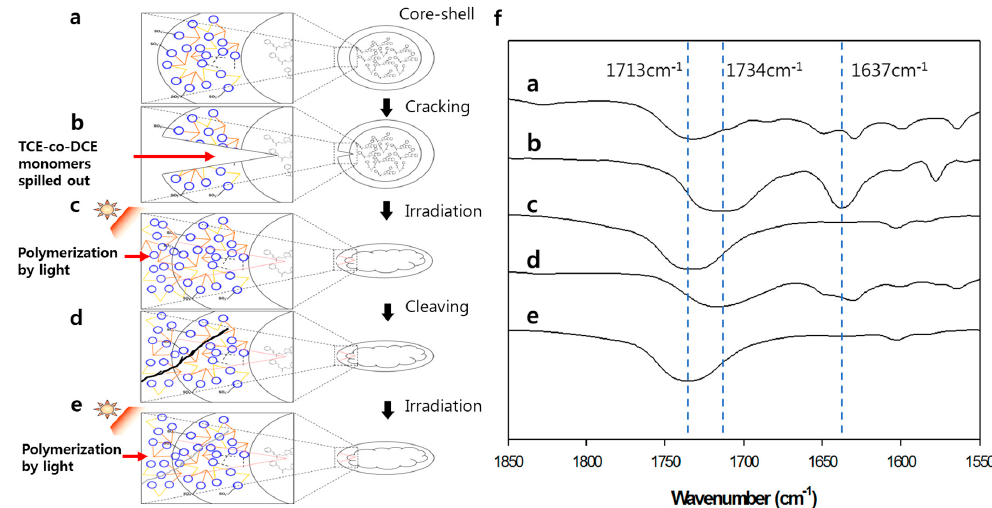
Figure 5. Repeatability of self-healing. ( a – e ) Schematics of core-shell-like microcapsules to repeatedly heal the crack. ( f ) FT-IR spectra for each step of repeated cracking and healing processes shown in ( a – e